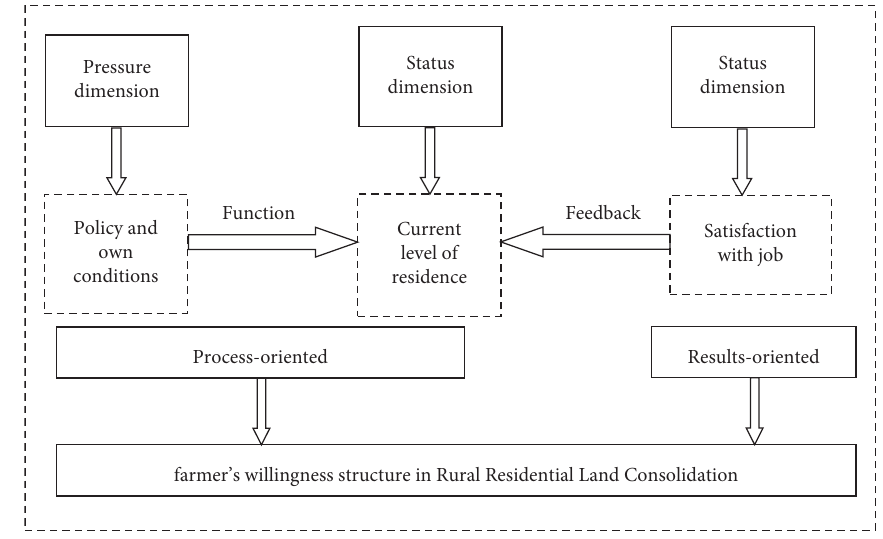
Figure 1: Schematic diagram of the overall framework for the construction of farmers’ willingness structure in rural residential land consolidation based on PSR theory. Table 2: Farmers’ willingness structure in rural residential land consolidation potential estimation.